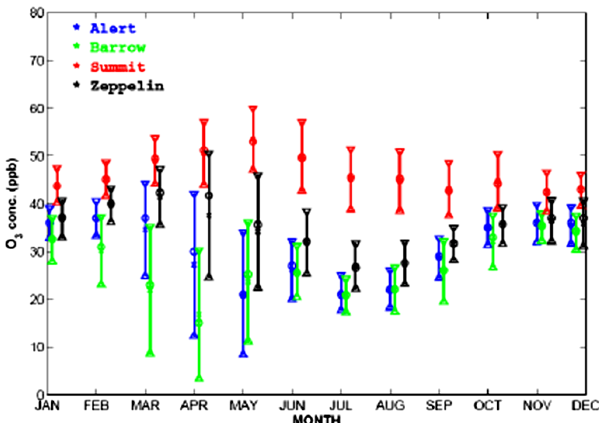
Figure 37. Seasonal cycle of O 3 at various surface sites in the Arc- tic. From Hirdman et al.